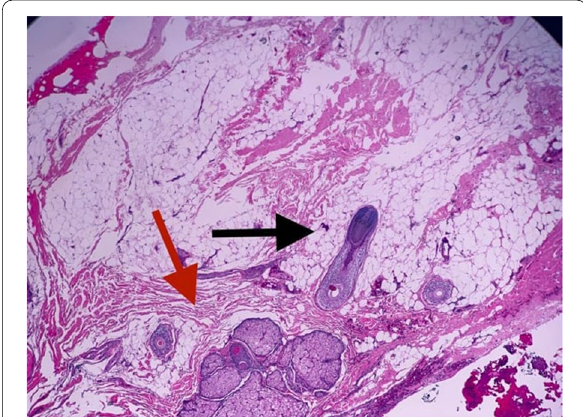
Fig. 5 Hematoxylin and eosin-stained histopathological picture in which the black arrow shows a hair shaft and the red arrow shows a sebaceous gland